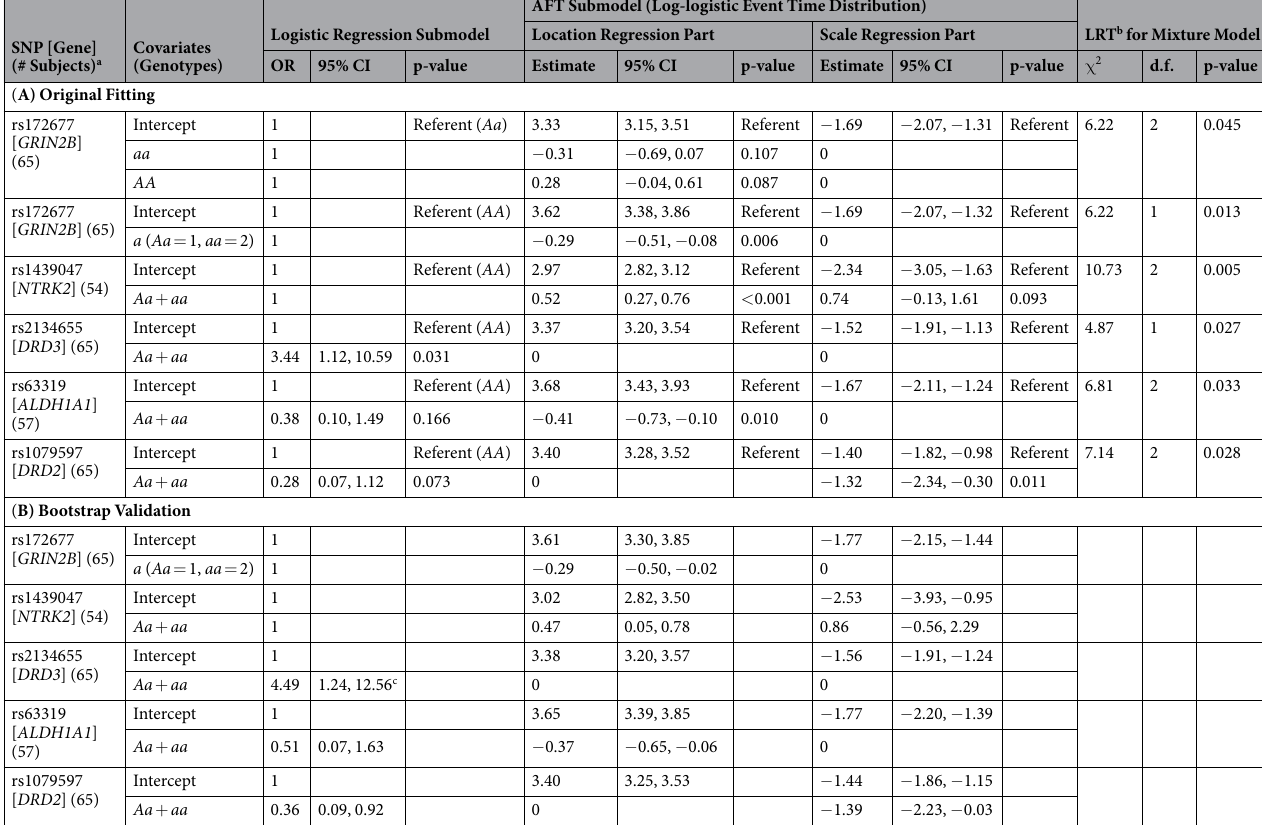
Table 1. (A) Single-SNP analysis by using the logistic-AFT mixture regression model. (B) Corresponding bootstrap validation results based on 400 bootstrap samples of size 65. a The sample size for each single- gene analysis. b Chi-squared statistic, degrees of freedom and p-value for the likelihood ratio test. c bootstrap percentile confidence intervals. Abbreviations: OR, odds ratio; CI, confidence interval; LRT, likelihood ratio test; d.f., degrees of